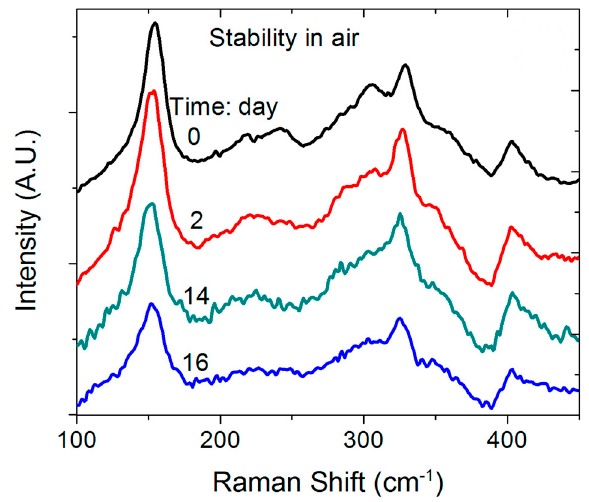
Figure 7. Raman spectra for 1T MoS 2 stored in air for di ff erent